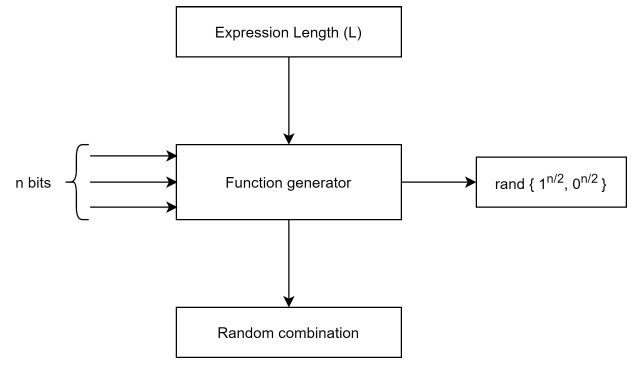
Figure 1. Logical block structure of SRFG.